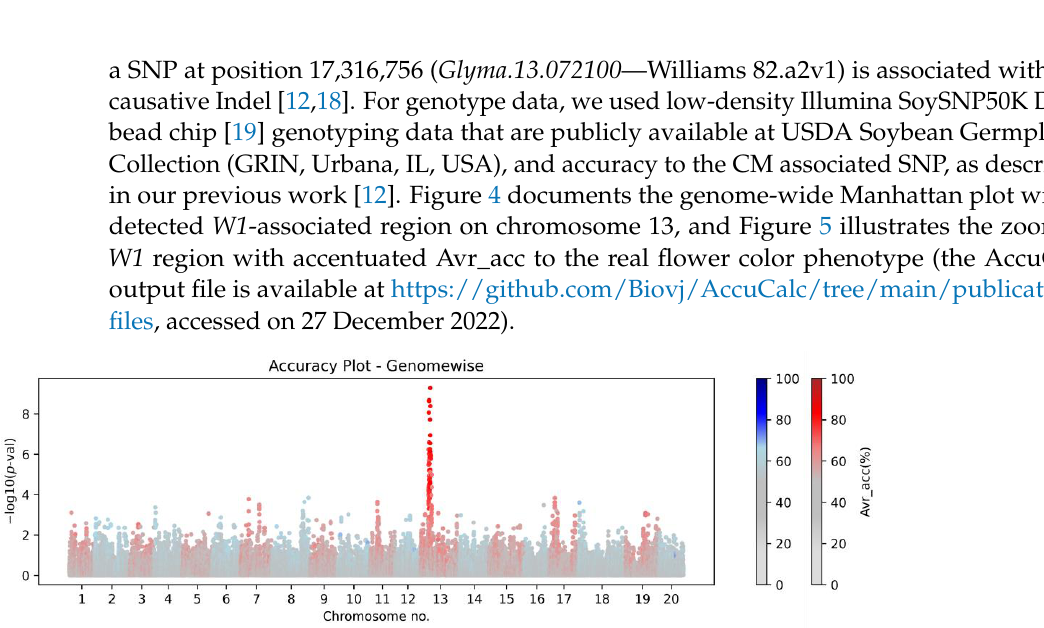
Figure 4. The AccuCalc genome-wise view of genome-wide association study data accentuated with calculated accuracy. The Manhattan plot for soybean data (Illumina SoySNP50K DNA bead chip genotyping data and purple/white flower color phenotype data). The Manhattan plot is accentuated with the average accuracy of the causative mutation-associated SNP on chromosome 13 at position 17,316,756: even chromosomes (blue-gray scale), odd chromosomes (red-gray scale). AccuCalc enables the accuracy Manhattan plot creation and provides a table with the accuracy calculation and summary information for every included variant in the analysis.